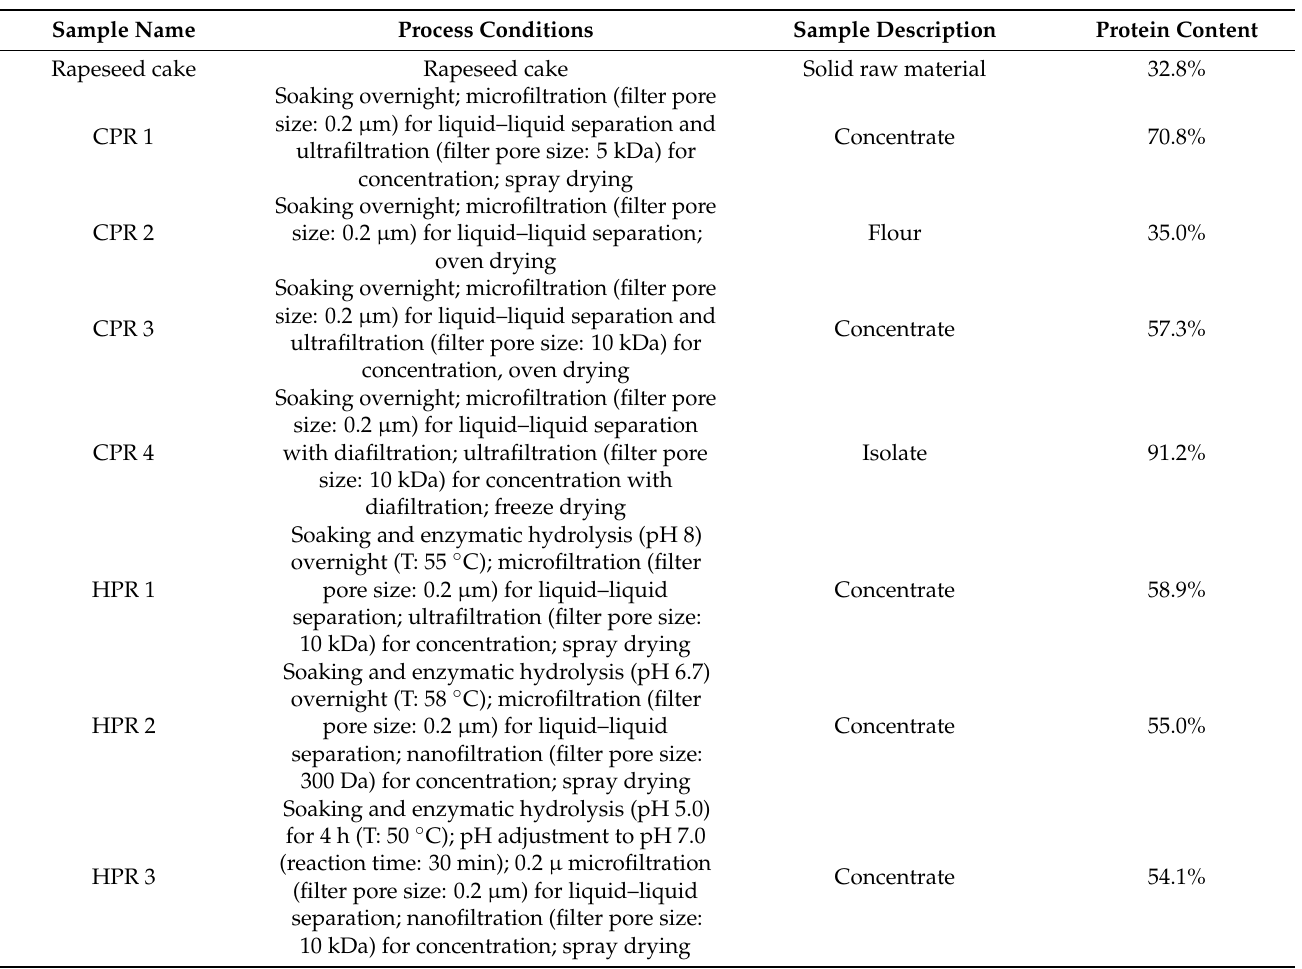
Figure 1. General process flow diagram for protein extraction from rapeseed cake. Table 1. Description of the process conditions used to obtain protein products from cold-pressed rapeseed cake (CPR) and hot-pressed rapeseed cake